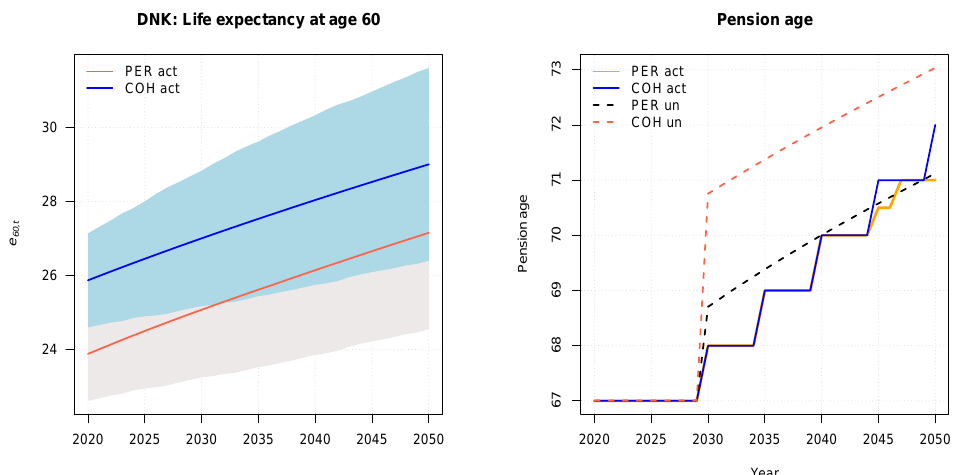
Figure 5. DNK: BME forecast of unisex period and cohort life expectancy and pension age along with 95% prediction